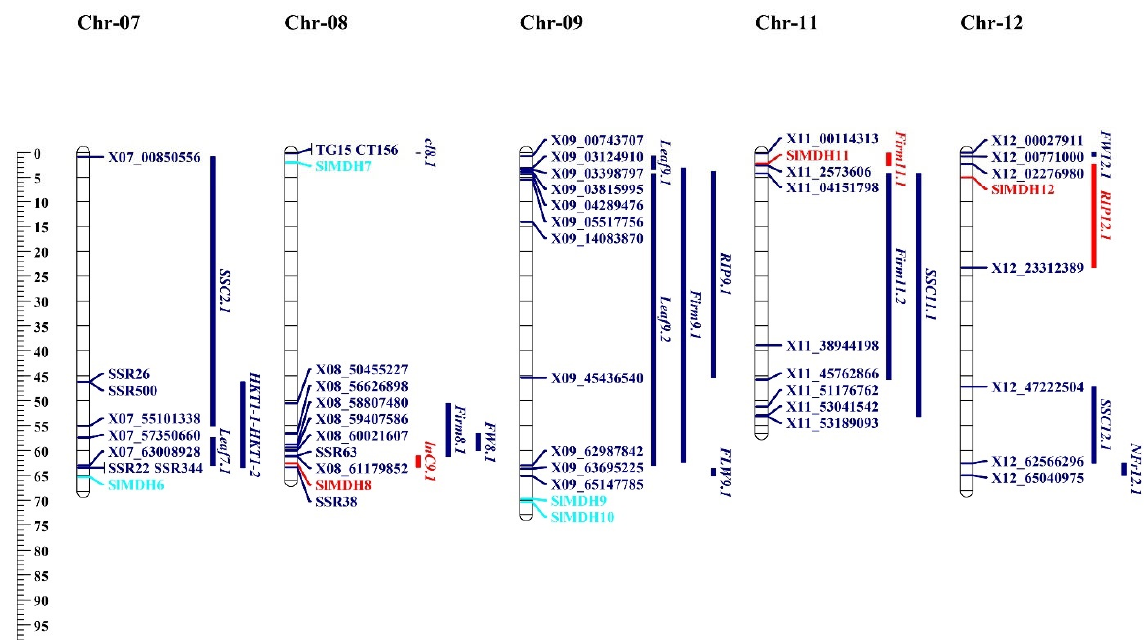
Figure 9. On the chromosomes of tomato, the MDH genes and the quantitative trait loci (QTLs) responsible for salt stress-related traits were found to be in close proximity to one another. This scale illustrates the relative physical locations of genes and QTL-linked markers in megabases (Mb). Genes located within the QTLs are illustrated with red color, while genes and QTLs not co-localized are represented with turquoise and blue colors.